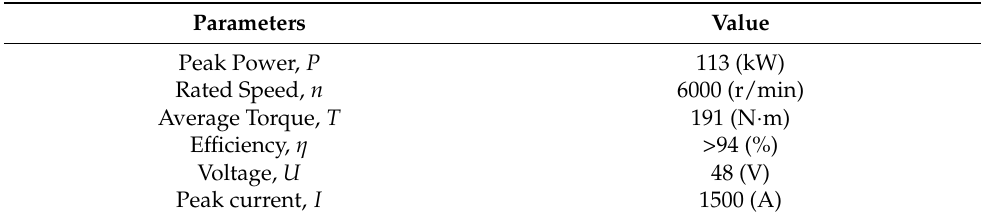
Table 1. Main specifications of MSPMSM